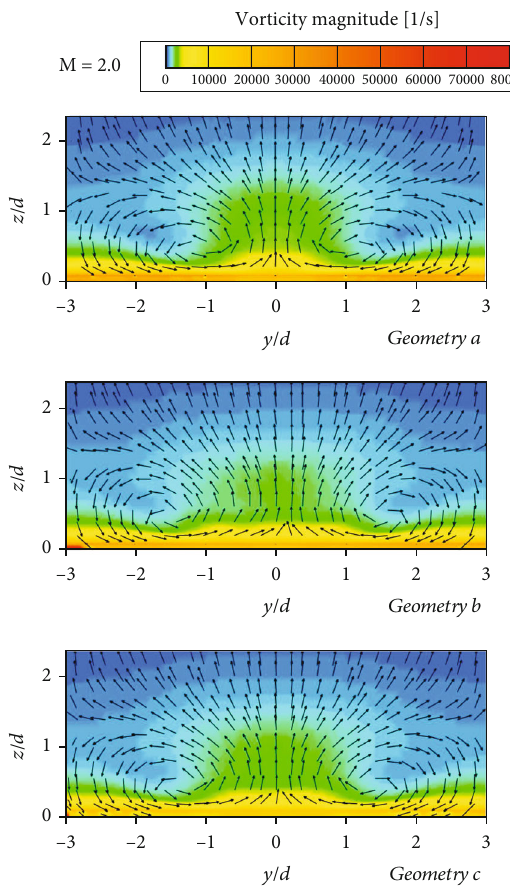
Figure 18: Vorticity magnitude contours and velocity vectors at x /d = 5 , for the three fi lm hole geometries, M = 2